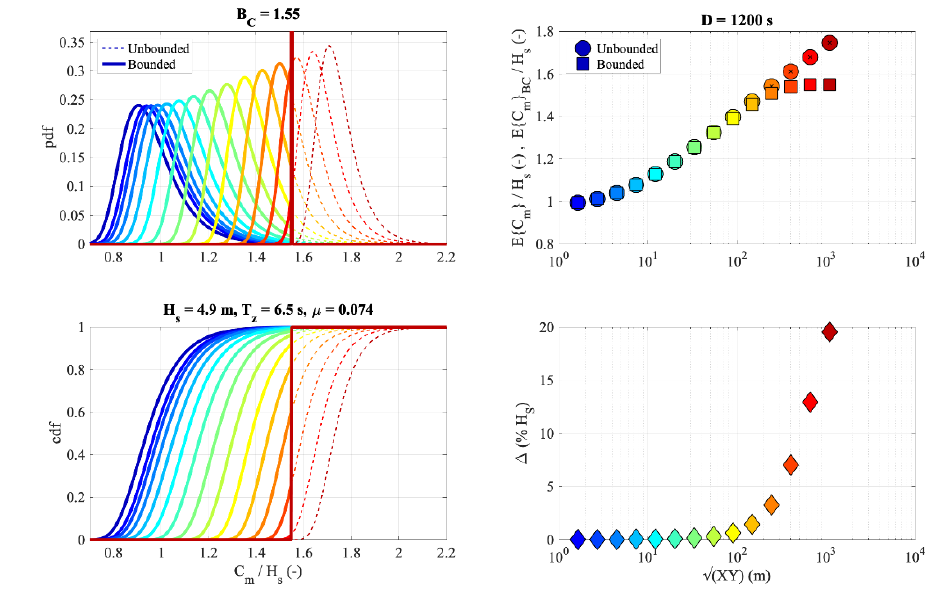
Figure 1. Space-time extreme crest heights C m . Example of unbounded Gumbel-like distribution and bounded distribution by imposing the upper bound max{ C m } = 1.55 H s ( B c = 1.55; see Section 3 for the choice of the threshold value). The temporal interval duration for the extreme assessment is fixed to D = 1200 s, whilst the sea surface area XY changes. (top-left) Unbounded (dashed line) and bounded pdf (solid line) color-coded from blue to red with growing sea surface area width ( XY ) 1 / 2 as in the top-right panel. (bottom-left) Unbounded (dashed line) and bounded cdf (solid line) with the same color code as the pdf. (top-right) Variation with ( XY ) 1 / 2 of normalized E{ C m } and E{ C m } BC , and (bottom-right) percentage relative error ∆ = (E{ C m } − E{ C m } BC ) / H s . Parameters of the distributions are computed using a directional wave spectrum ( H s = 4.9 m; zero-crossing mean spectral period T z = 6.5 s; µ = 0.074) obtained by running the wave model WAVEWATCH III ® (see Section 3 for a description of the numerical runs).